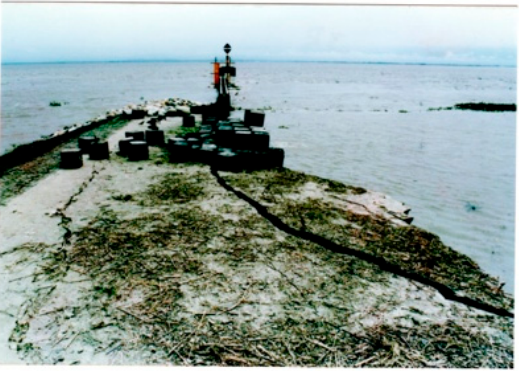
Figure 13. Kamarjani test site groyne G-3 with reserve stock cubes on the crest during an ongoing flow slide (photograph: project FAP21/22).